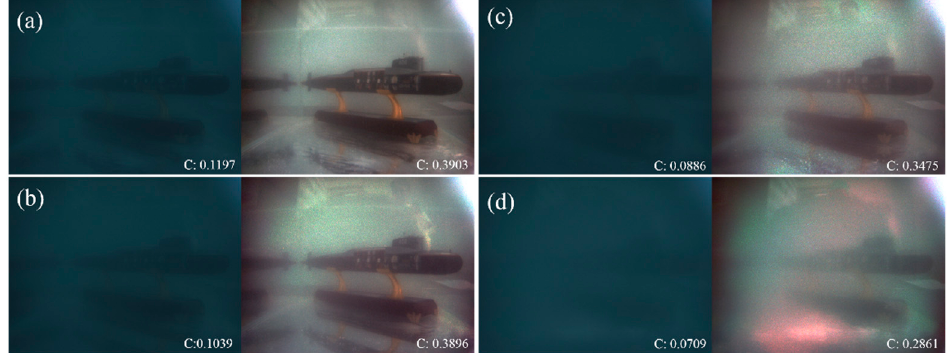
Figure 8. Underwater descattering experimental results. ( a )–( d ) are the original intensity images (left one of each group) and dehazed images (right one of each group) from light scattering to dense scattering conditions.